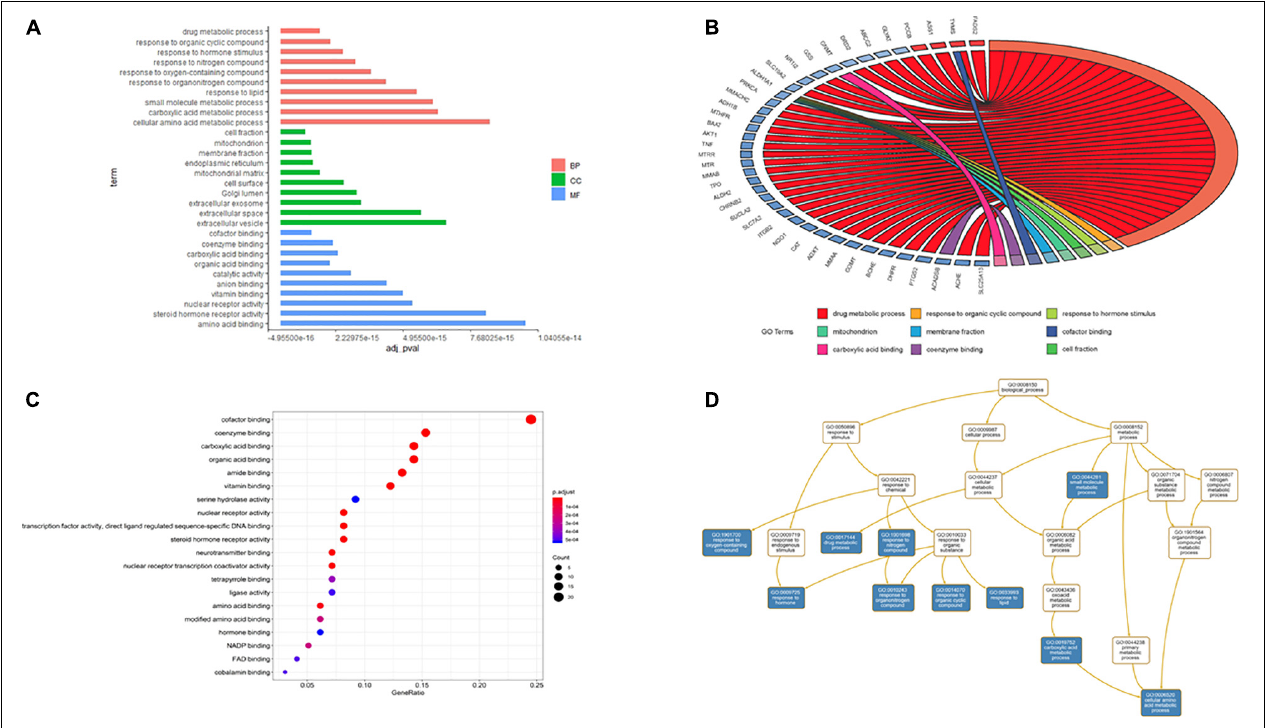
FIGURE 6 | Gene ontology terms of candidate targets of EJSW against ITP. (A) The results of enrichment analysis containing BP, CC, MF. (B) The relationship of genes and GO terms (top3 of BP, CC and MF) based on the results of GO analysis. (C) The top 20 GO functional categories with p < 0.05 were selected. (D) The hierarchical relationships of GO terms